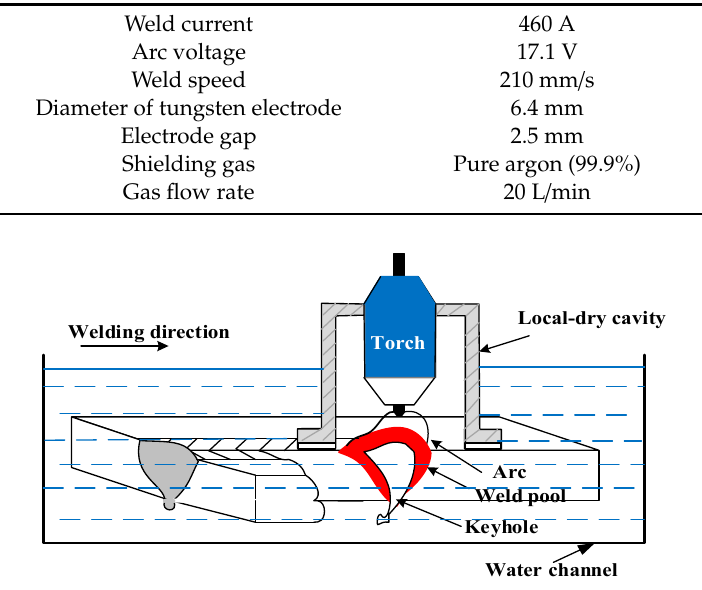
Table 2. Welding parameters used during the underwater local-dry keyhole tungsten inert gas (ULK-TIG) welding experiments.